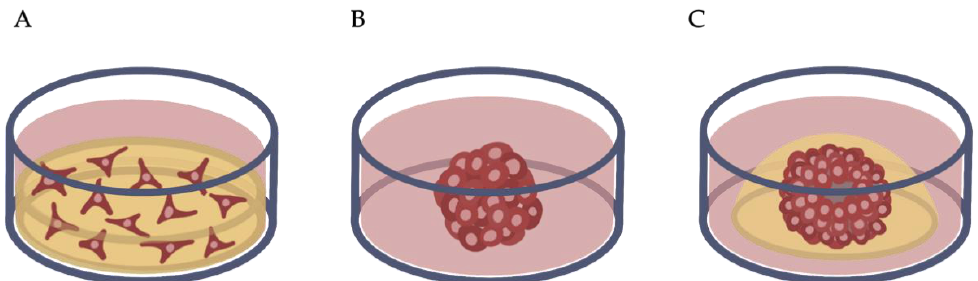
Figure 2. Three-dimensional cell culture models. ( A ) Hydrogel culture: cells are embedded in a scaffold material with a supernatant of culture medium. ( B ) Spheroid culture. ( C ) Organoid culture: cells are embedded in an extracellular matrix.